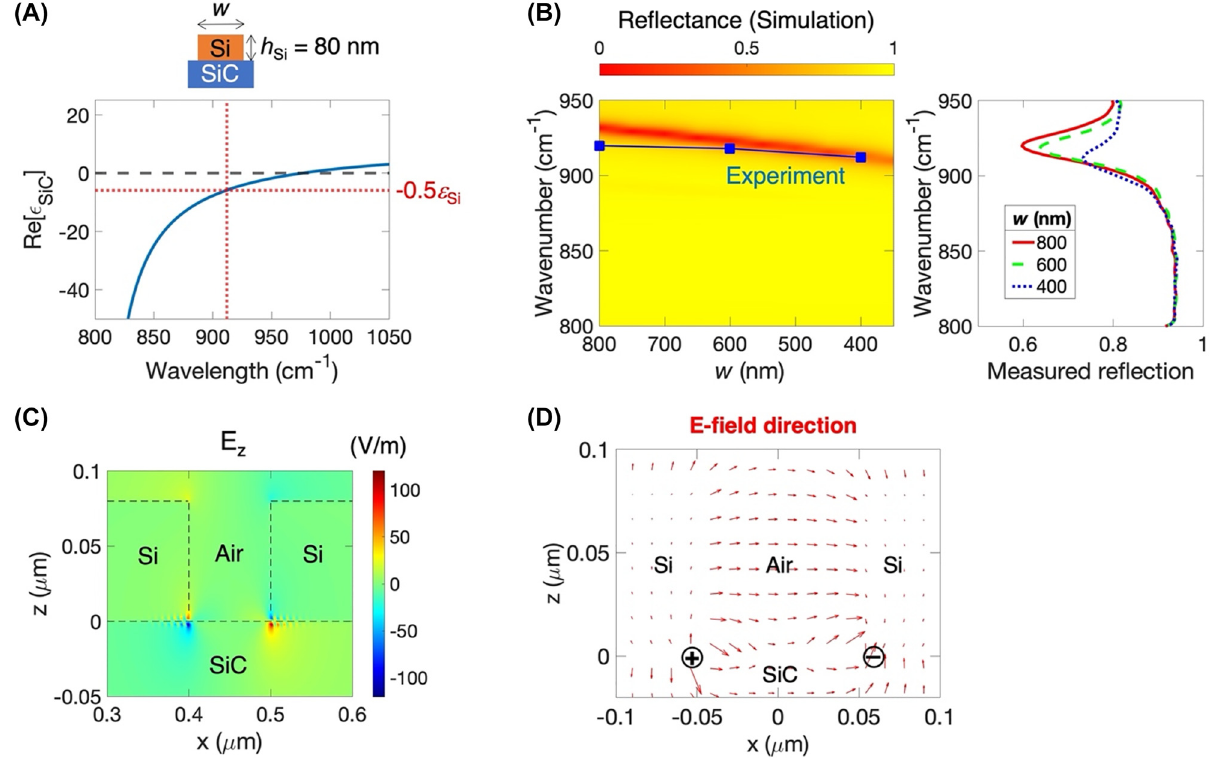
Figure 4: Localized surface phonon polaritons on a thin silicon grating structure on 6H-SiC. All samples have an 80 nm thick silicon and a with respect to a frequency of light. Fröhlich’s 900 nm grating period. The cavity length w varies. (A) The real part of 6H-SiC permittivity 𝜀 SiC void resonance condition for a dipole of localized surface phonon polaritons can be determined when Re[ 𝜀 ] = − 0.5 𝜀 (dashed line), where SiC Si 𝜀 is the permittivity of silicon. Due to the flat silicon layer with a gap structure, localized dipole charges are induced at the corner of the Si boundary between silicon and 6H-SiC. (B) Measured and simulated reflectance with respect to the cavity length w (or air gap between two cavities). Left: color map plot shows reflectance given by full-wave simulation with respect to frequency and the cavity length. The dark red line represents absorptions due to the localized SPhPs. Blue squares show absorption frequencies given by reflection measurement under normal incident, perpendicularly polarized to the grating. Both resonances show redshifts. Right: measured reflectance spectra of three distribution of the localized SPhPs when the cavity length is different cavity widths of 800 nm, 600 nm, and 400 nm. (C) Electric field E z 800 nm. The electric field is highly localized only at the edge of the Si and SiC boundary. The opposite polarization distribution indicates dipole charges at the edge boundary. Surface charge oscillation is observed and decays away from the localized charges. The decaying polaritons are required for a phase matching of electric fields from the dipolar charge. (D) The vector plot presents the electric field profile of the dipolar mode, which clearly shows localized charges at the edge of the Si and SiC